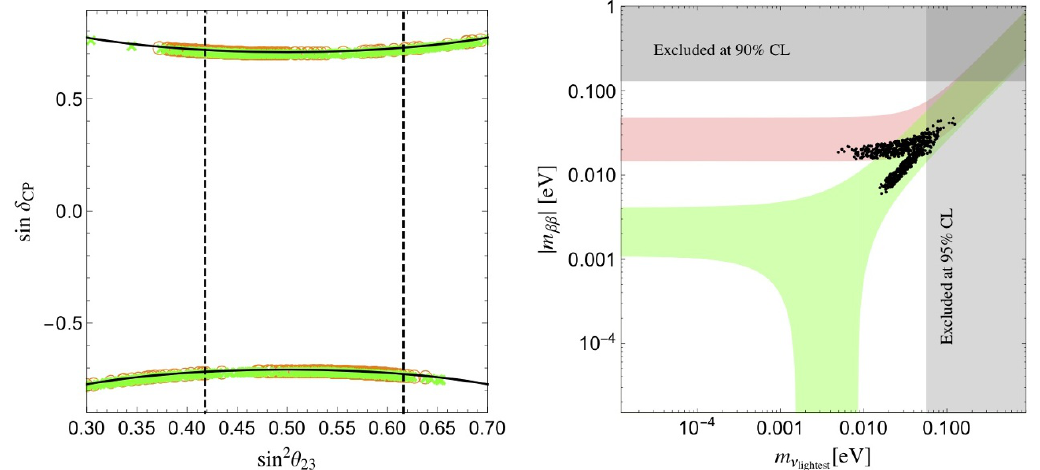
Figure 3 . The results for n = 4 (with (cid:13) = 0, x = (cid:0) (cid:17) 1 = (cid:17) 2 = 1) and (cid:15) max = 0 : 1. In the left panel, the orange circles (green crosses) correspond to the normal (inverted) ordering in the neutrino masses. All these points are in agreement with global (cid:12)t values of (cid:1) m 2 (cid:18) 13 within 3 (cid:27) . The region between the vertical dashed lines correspond to experimentally allowed 3 (cid:27) range of sin 2 (cid:18) 23 . The black contours represent the correlation given by the (cid:12)rst of eq. (4.11). In the right panel, all the points are in agreement with the results of global (cid:12)t of neutrino oscillation data within 3 (cid:27)